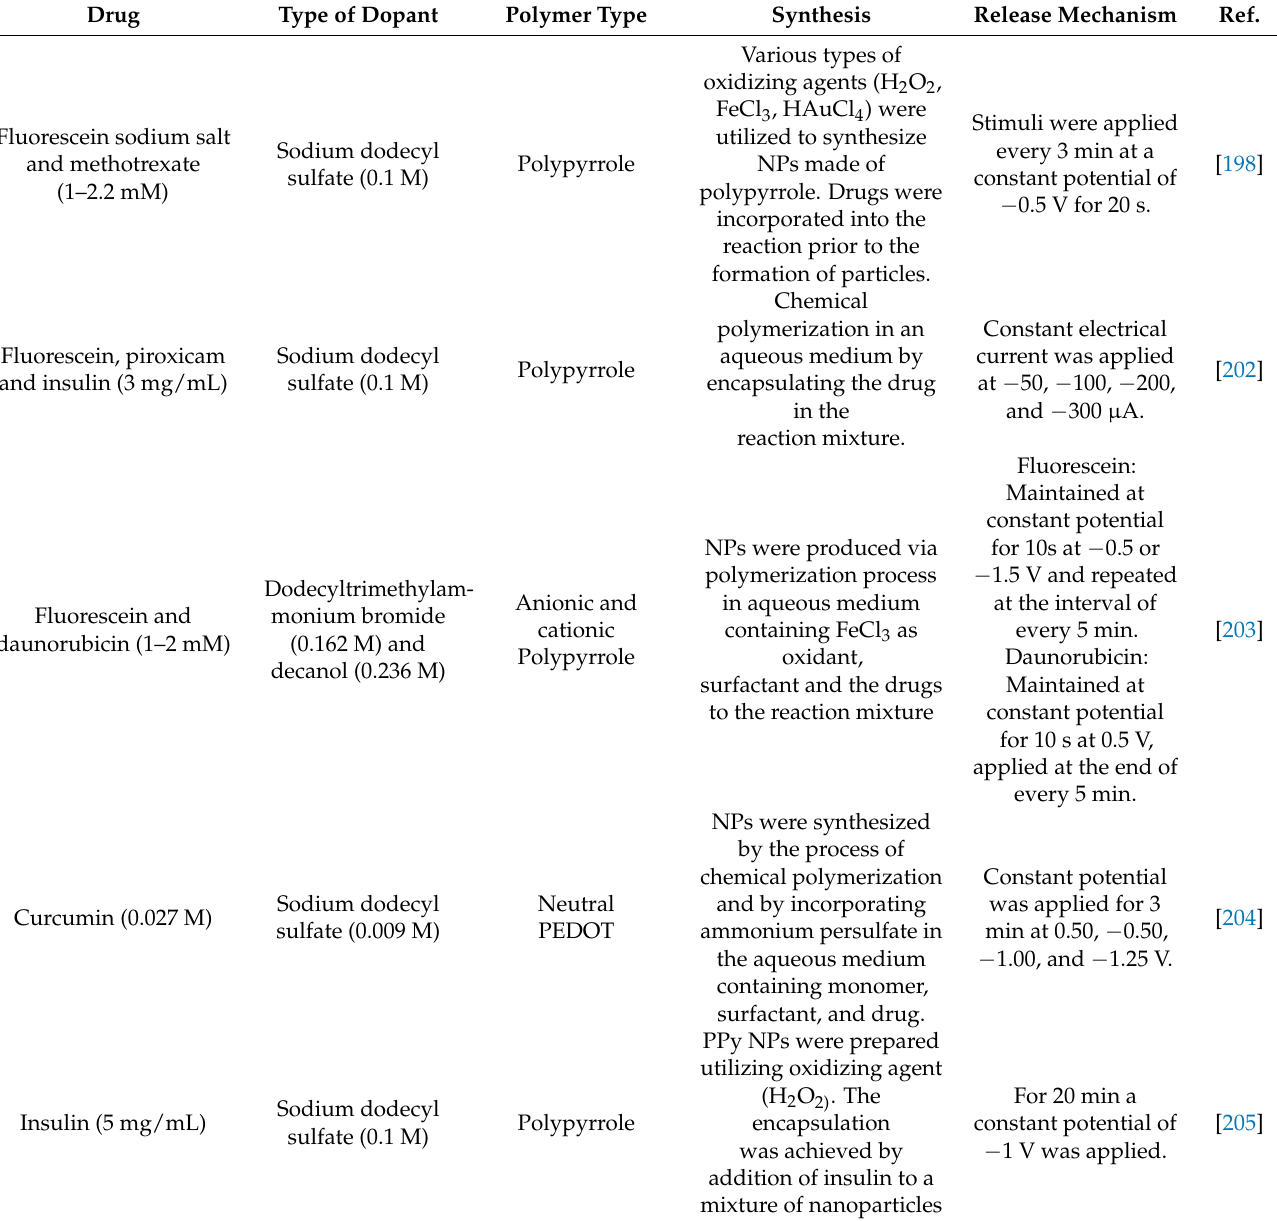
Table 4. Brief overviews of various DDSs incorporating conductive polymer-based